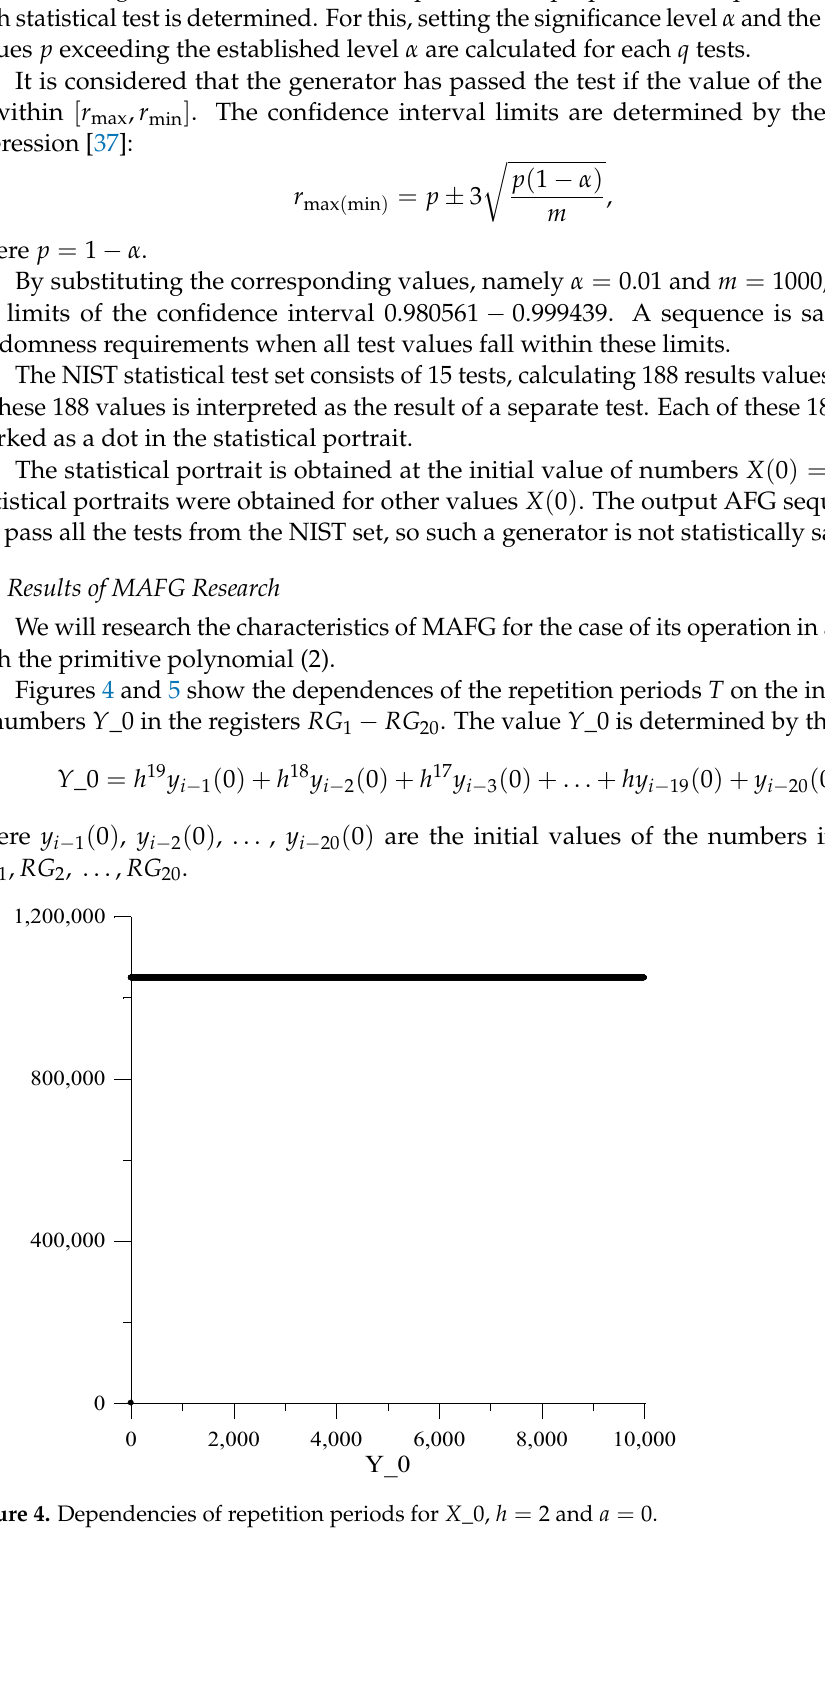
Figure 5. Dependencies of repetition periods for _ 0 X , 3 h = and